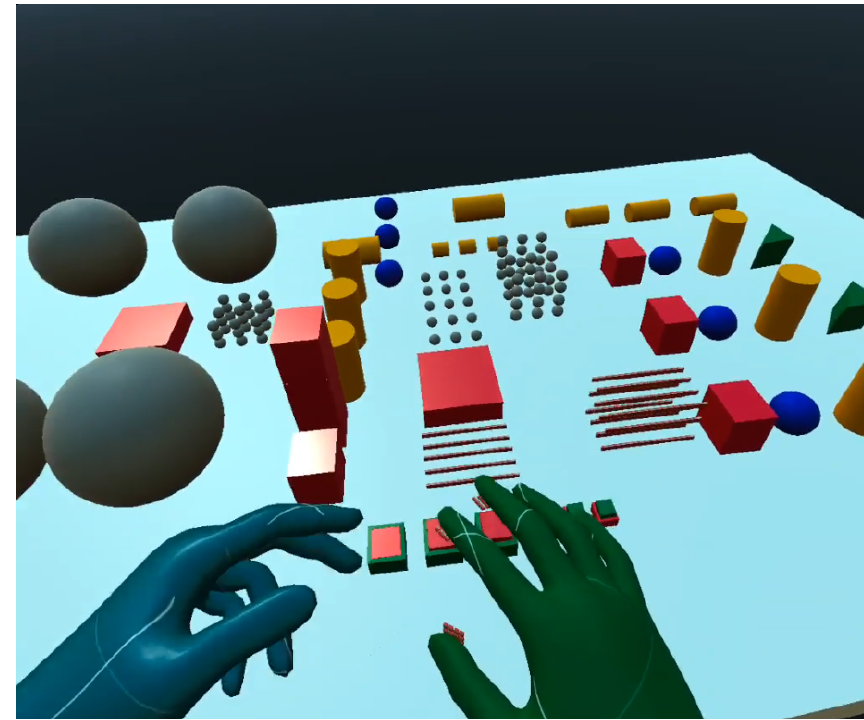
Figure 16. 3D VR